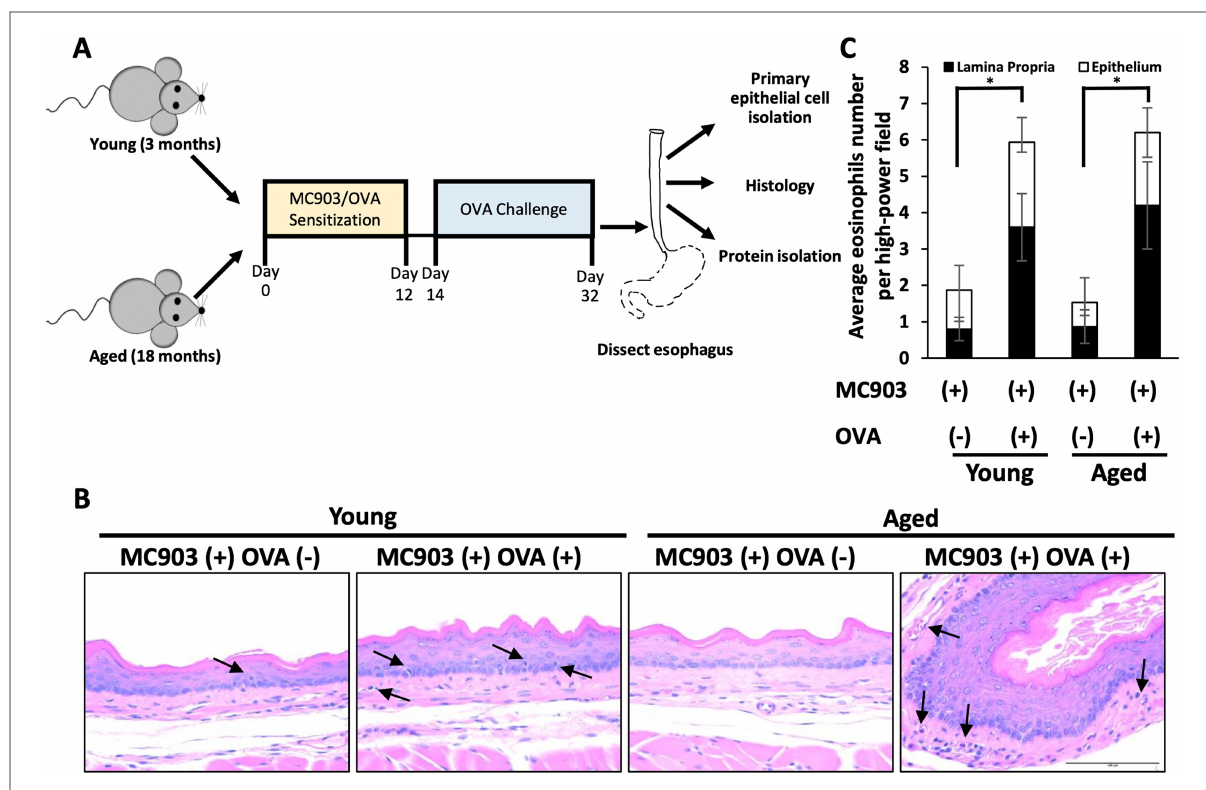
FIGURE 1 Impact of MC903/ovalbumin (OVA)-induced in fl ammation in young and aged mice. ( A ) Schematic of sensitization-challenge protocol for MC903- OVA-induced model of eosinophilic esophagitis. C57BL/6 mice were sensitized for 12 days with MC903±OVA via ear scratch to induce development of atopic dermatitis – like skin lesion. From days 14 – 32, OVA-treated mice were challenged via intragastric OVA every other day with continuous access to OVA-supplemented drinking water. ( B ) Representative H&E-stained sections from mice treated with MC903±OVA. Arrows indicate eosinophils. Scale bar, 100 μ m. Data are from two independent experiments including four groups: young MC903(+) OVA( − ) ( n =5); young MC903(+) OVA(+) ( n =6); aged MC903(+) OVA( − ) ( n =6); and aged MC903(+) OVA(+) ( n =6). ( C ) Eosinophils were counted in lamina propria and epithelium across three high-power fi elds (HPF; 400X magni fi cation) per animal. Bar graph represents average per experimental group (mean± SEM). Two-way ANOVA testing with Tukey ’ s correction was used to determine signi fi cance. * p ≤